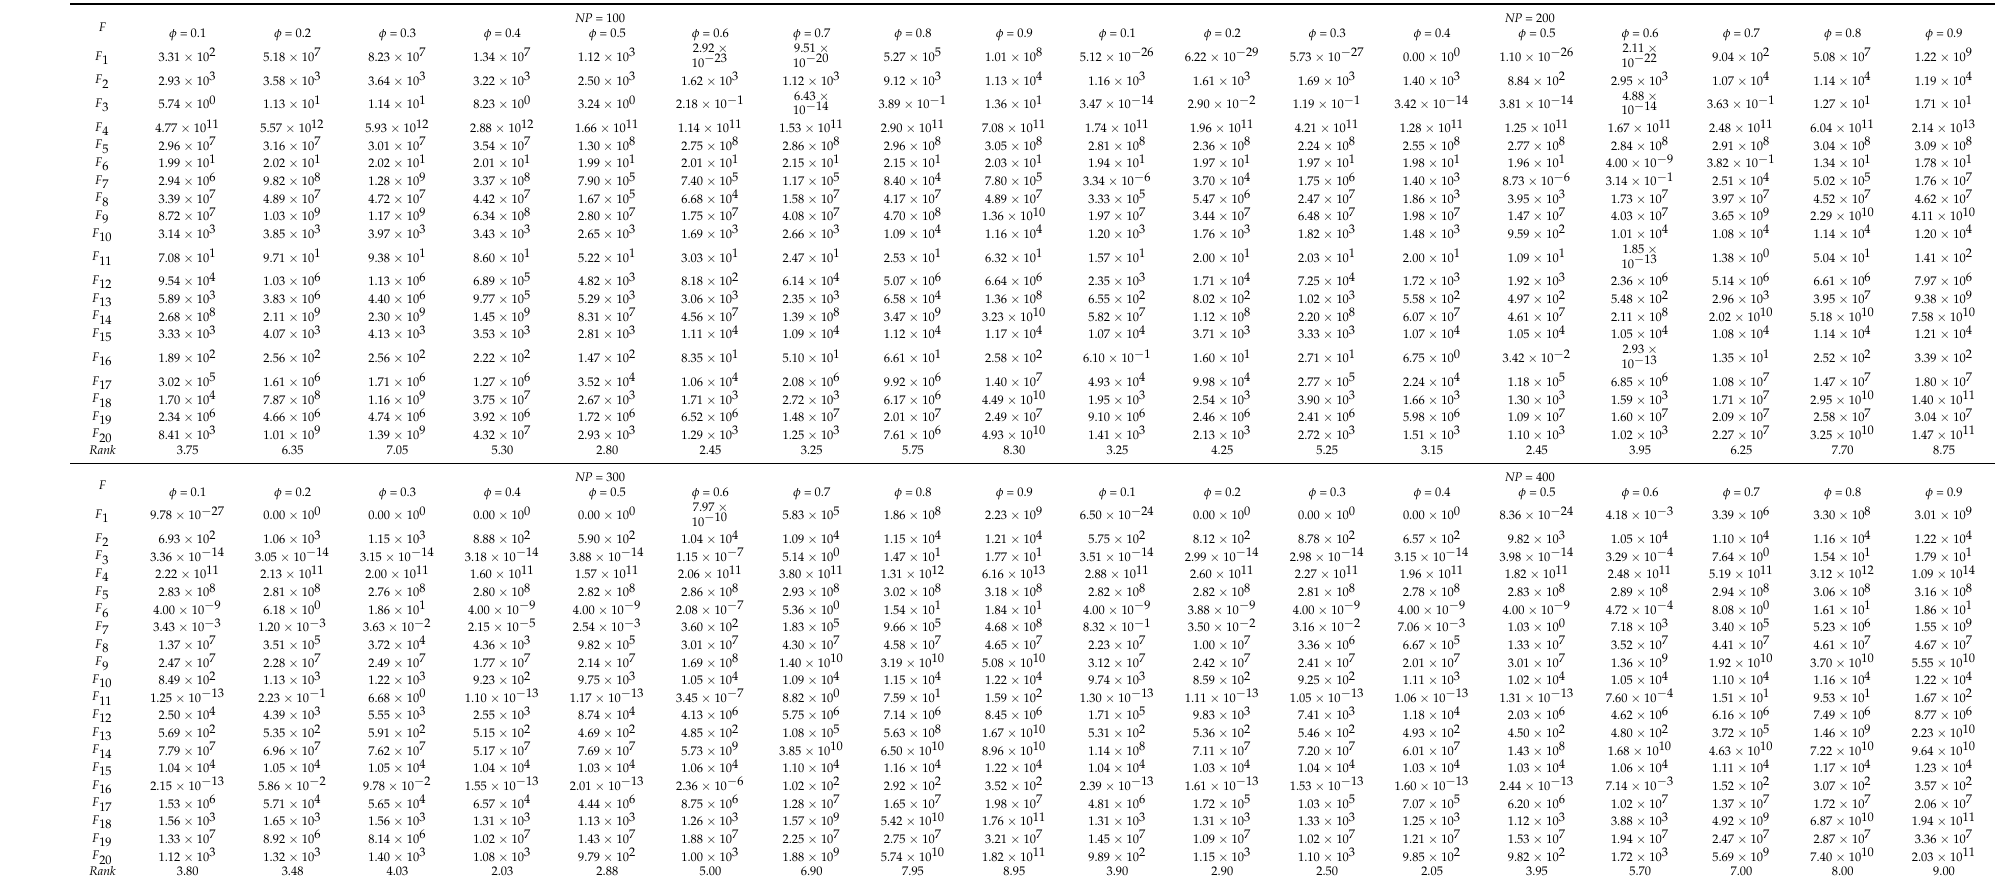
Table 1. Comparison results among DGCELSO with different settings of NP and φ on the 1000-D CEC’2010